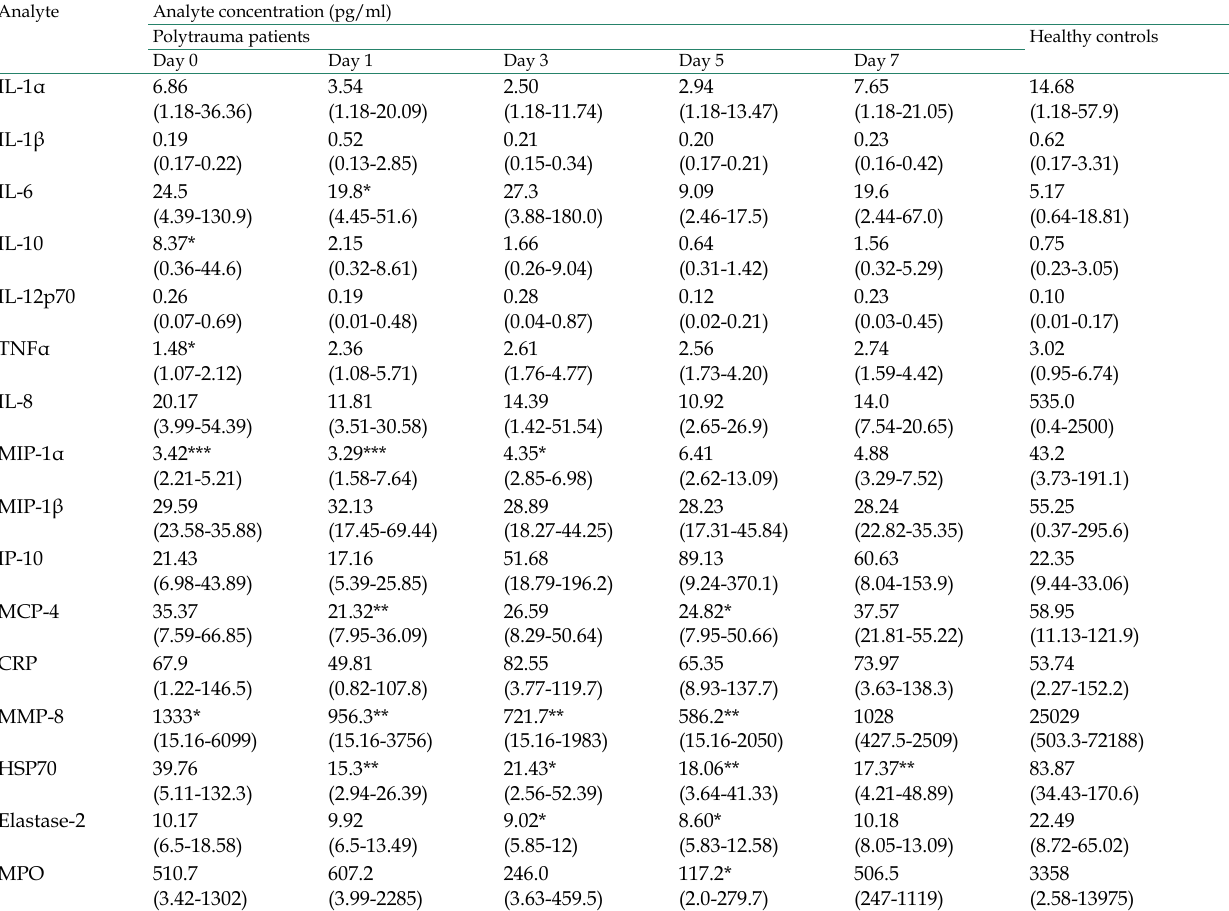
Table 1: Quantification of serum-resident factors in polytrauma patients compared to healthy donor sera.